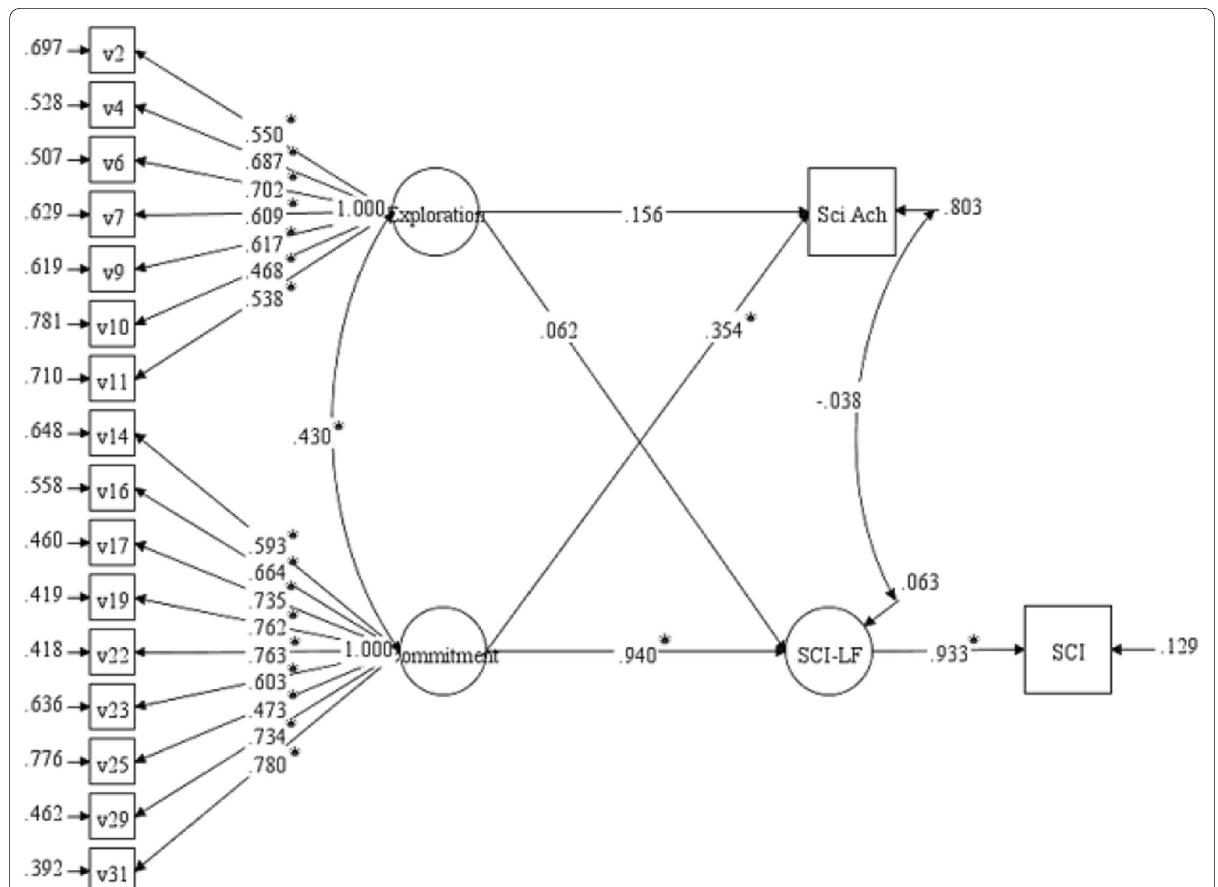
Fig. 1 SEM investigating the convergent validity of science identity with science achievement and science career interest. * p value < .05. Results are standardized. Sci Ach Science Achievement (measured as a weighted variable based upon student academic success in science and the rigor = of the science courses the student pursued); SCI‑LF Science Career Interest Latent Factor; SCI Science Career Interest (measured as a composite = = score of the Science Subscale from the